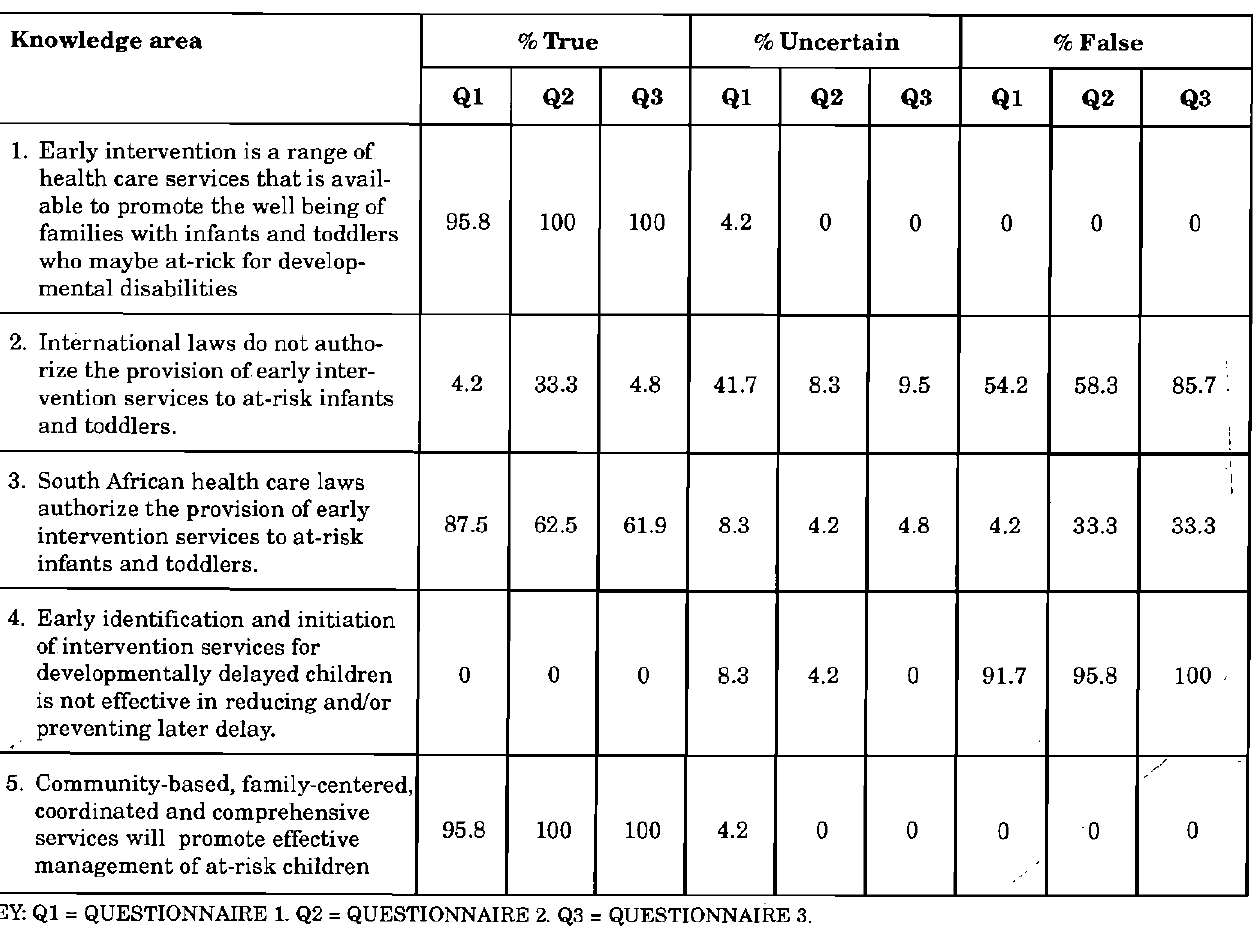
TABLE 4: Community nurses' common knowledge regarding early intervention as evident during the pre- and post-training